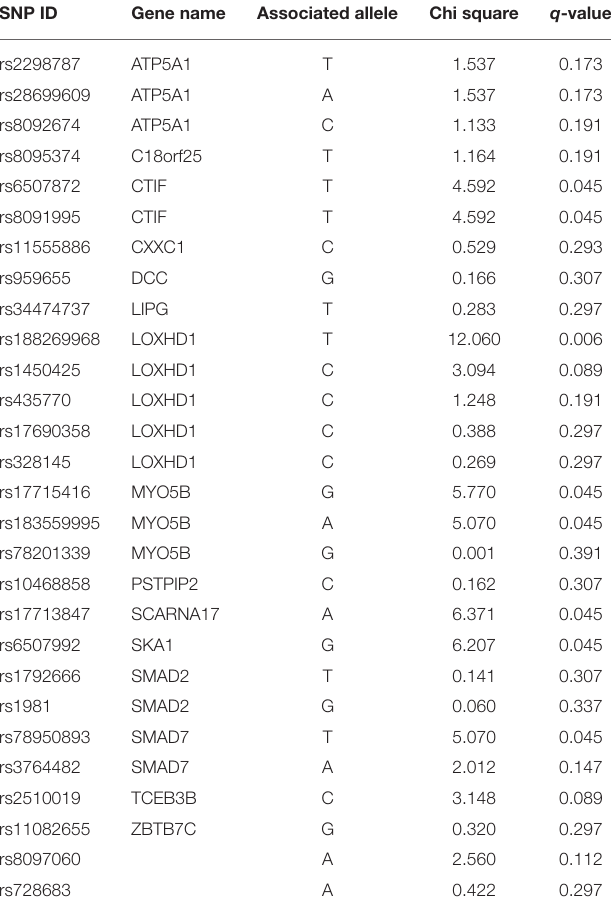
TABLE 3 | Results from analysis of association between SNPs genotyped vs. NSCL/P risk in the family. SNP